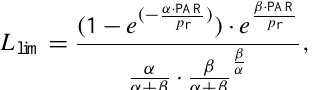
Table 3. Comparison of temperature limitations in ecosystem mod- els. Meso stands for for mesozooplankton, micro for microzoo- plankton, cocco for coccolithohores, and nano for nanophytoplank-